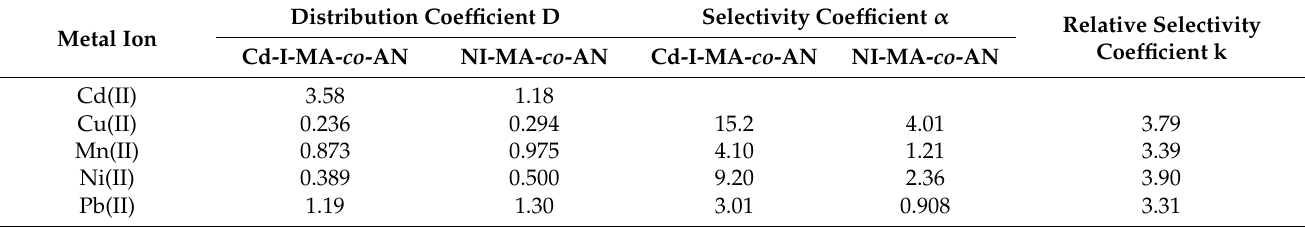
Table 3. Adsorption selectivity parameters of Cd-I-MA- co -AN and NI-MA- co